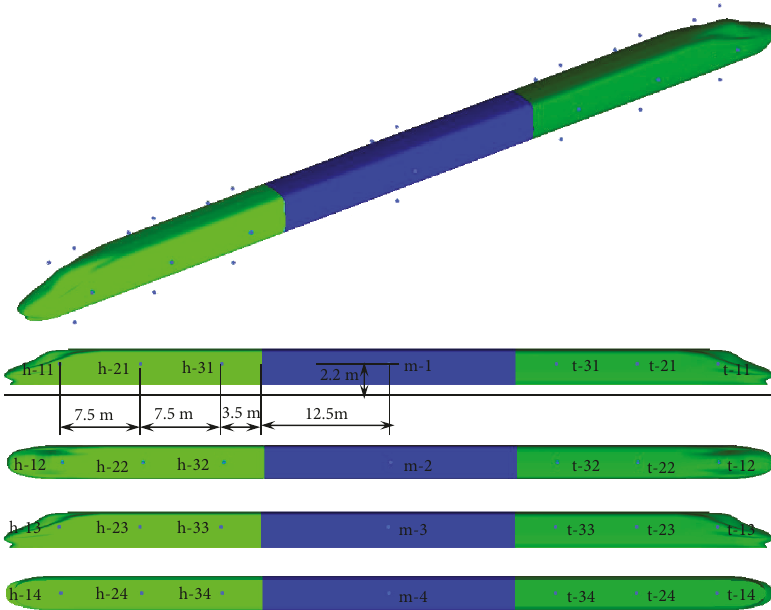
Figure 10: Layout of pressure measurement points on the train